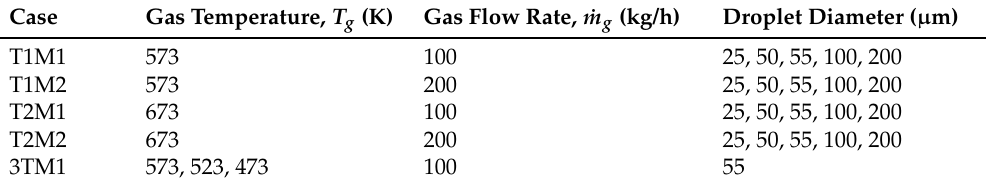
Table 4. Operating parameters for hot-cross flow cases (Wall temperature T w is assumed equal to T g